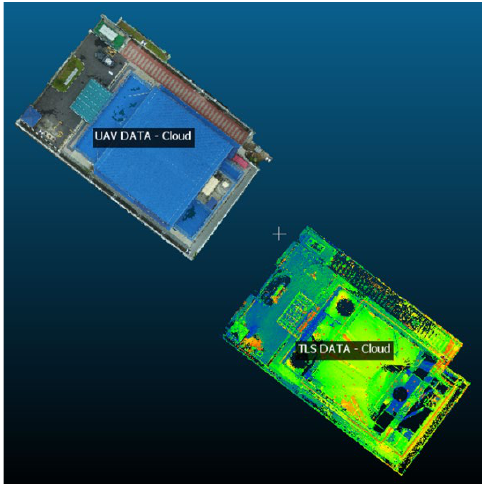
Figure 13. UAV and TLS point cloud (top